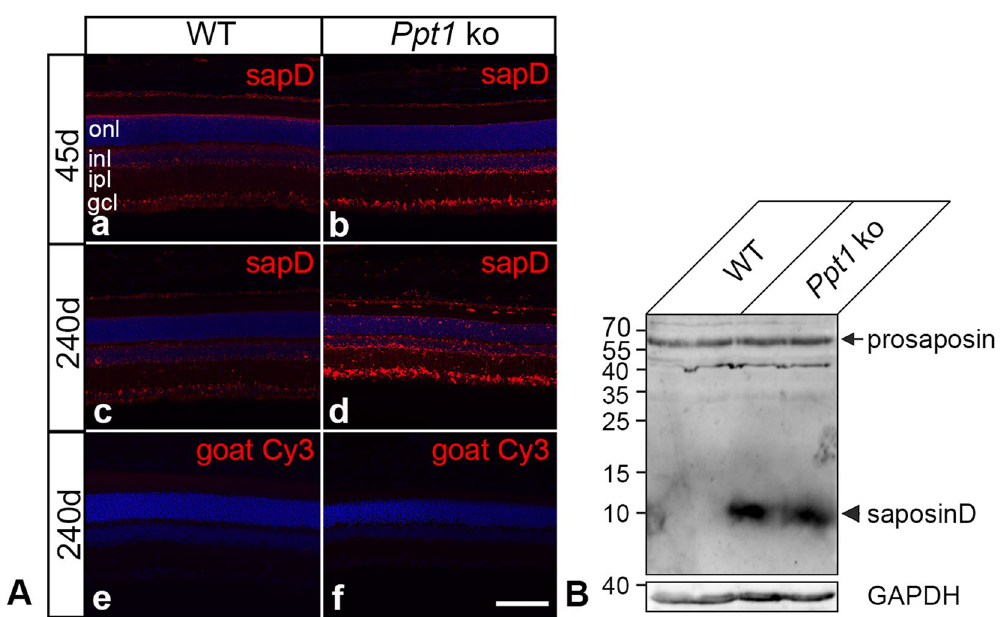
Figure 2. Accumulation of Saposin D in Ppt1 ko retinas. ( A ) Immunohistochemical analyses revealed moderately and markedly elevated levels of saposin D in 45- (b) and 240-day-old Ppt1 ko retinas (d) respectively when compared to age-matched wild-type retinas (a and c, respectively). No fluorescence signal was detectable when wild-type (e) or mutant (f) retinal sections were incubated with secondary antibodies only. ( B ) Immunoblot analyses confirmed markedly increased levels of saposin D (arrowhead) in 240-day-old mutant retinas, and revealed similar levels of prosaposin (arrow) in both genotypes. GAPDH immunoblotting was performed as a loading control. Positions of molecular mass markers are indicated. Uncropped blots are shown in Supplementary Fig. 5. gcl: ganglion cell layer; inl: inner nuclear layer; ipl: inner plexiform layer; onl: outer nuclear layer. Scale bar in (f) (for a–f): 100 µ